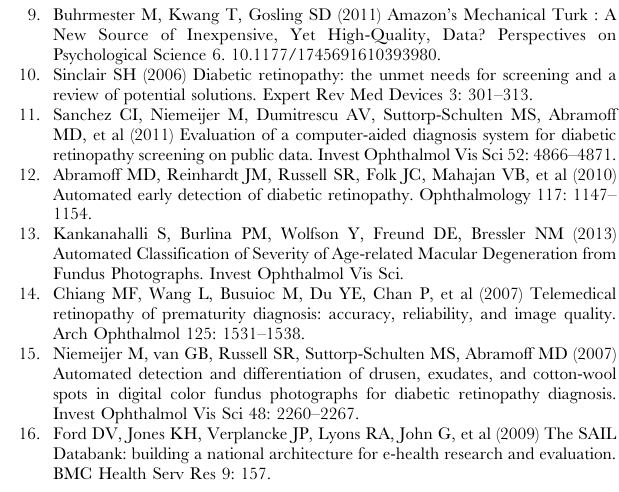
Figure S1 An example of a typical questionnaire each KW was asked to complete. Figure S2 An example of an image with a mild abnormality. Figure S3 An example of an image with a mild abnormality. Figure S4 An example of an image with a severe